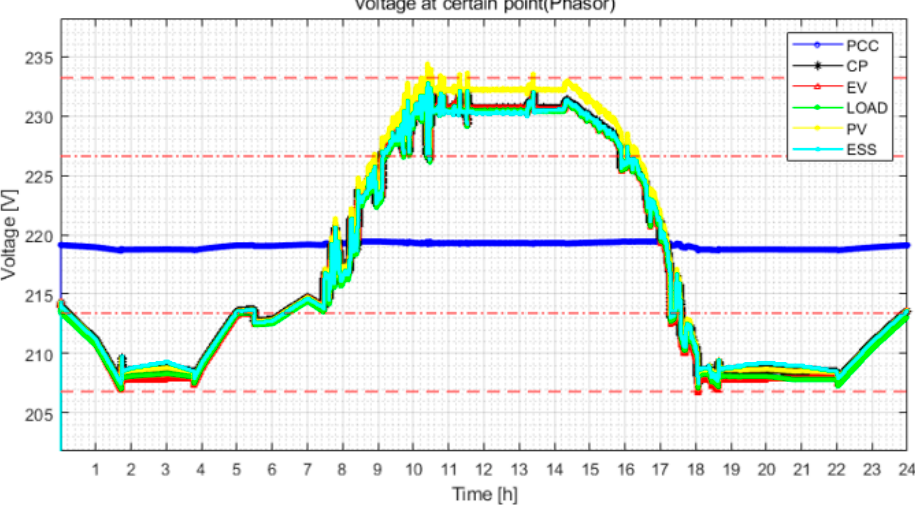
Figure 15. Analysis (voltage) of hosting capacity characteristic at EVC infrastructure with ESS.